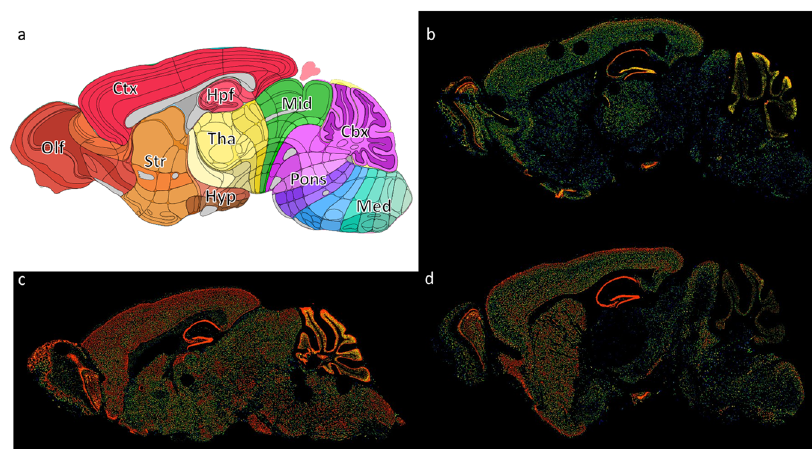
Fig. 2 Expression data for adult mouse sagittal brain sections in Allen Brain Atlas for three candidate genes. a Anatomical annotations overlap layer of mouse brain areas in a sagittal overview from the Allen Mouse Brain Atlas and Allen Reference Atlas - Mouse Brain, at the same slice position as b and c and d . b NAV2 expression layer data (mouse.brain-map.org/experiment/show/69443367). c ANK2 expression layer data (mouse.brain-map.org/experiment/show/68844707). d CACNA1E expression layer data (mouse.brain-map.org/experiment/show/ 69236897). Each expression cube is color-coded by average expression intensity ranging from blue (low intensity) through green to red (high intensity). Ctx cortex, Hpf hippocampal formation, Tha thalamus, Hyp hypothalamus, Str striatum, Olf olfactory bulb, Mid midbrain,